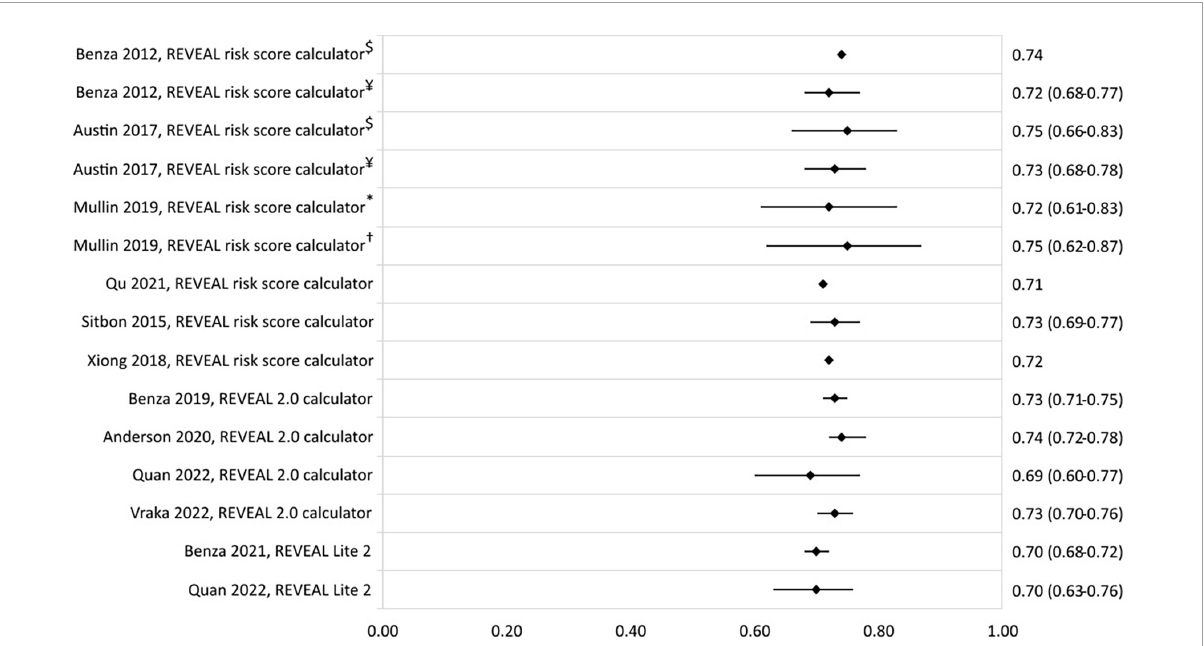
FIGURE2 C-statistic (95% CI) of the development and validation of REVEAL risk stratification models. $ Derivation cohort, (cid:85) validation cohort, ∗ JHPHP, and † PHAROS.